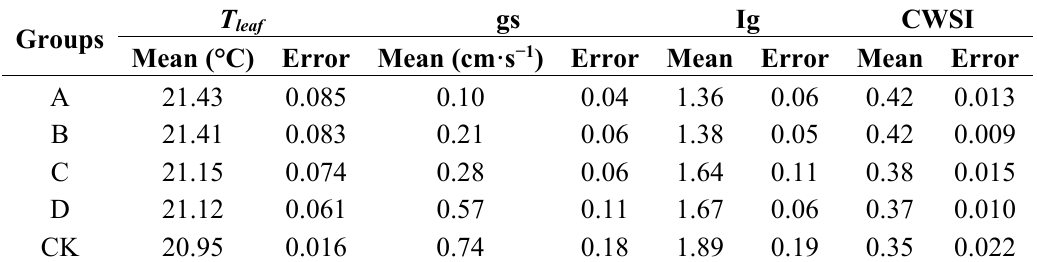
Table 5. Average temperatures of leaf ( T leaf ), stomatal conductance (gs) and stress indices (Ig and CWSI ) for canopies subjected to different treatments, and the error ( σ ) calculated from the square root of the residual mean square from ANOVAs of all treatments.